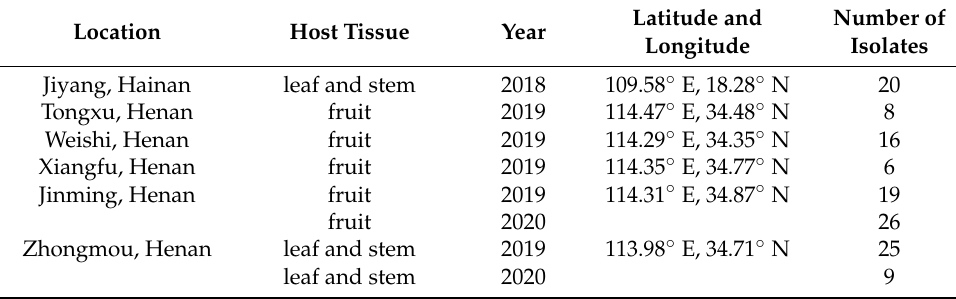
Table 1. A list of Colletotrichum isolates collected from Citrullus lanatus in